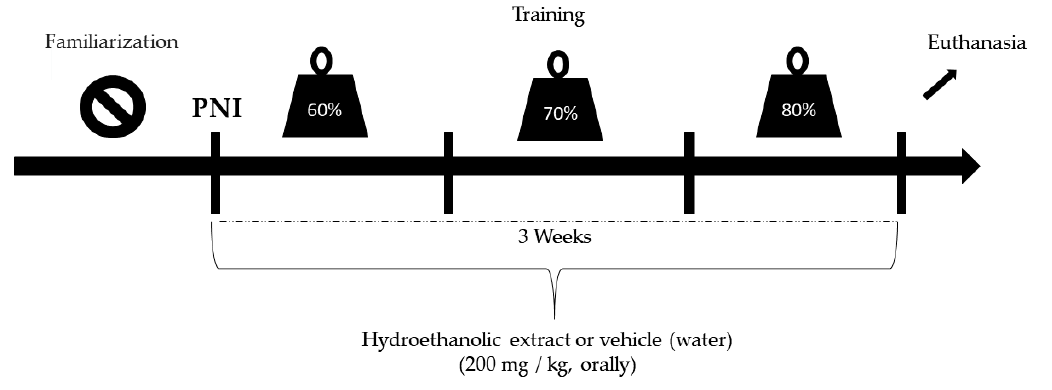
Figure 1. Study Figure 1. Study design.